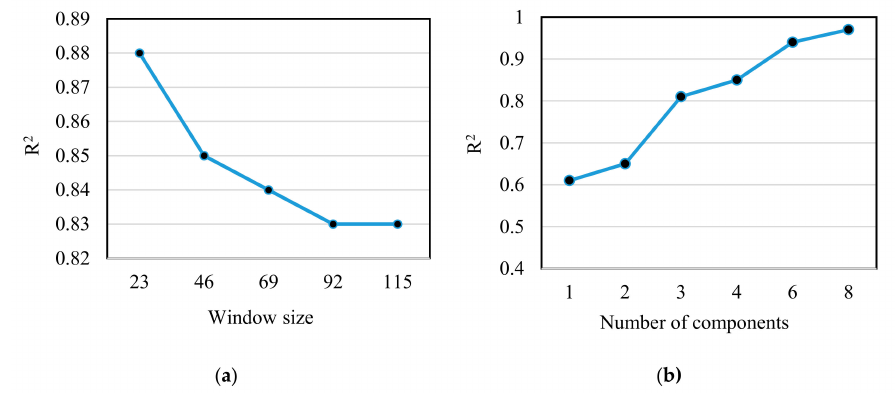
Figure 5. R 2 values between the original data and reconstructed data by SSA in a time series with 345 pieces of data for di ff erent window sizes ( a ) and for di ff erent number of components ( b